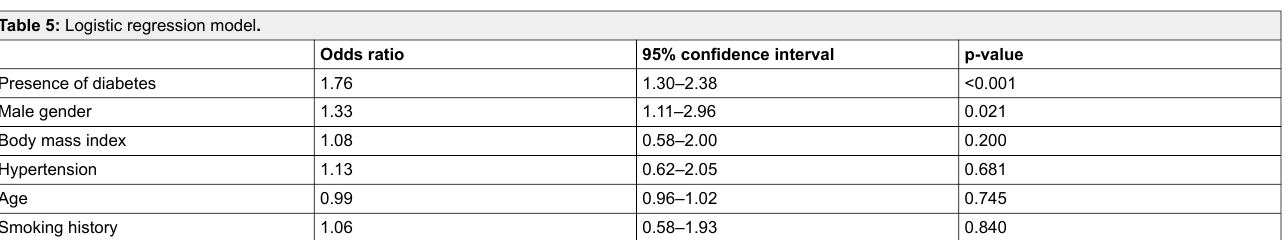
Table 5: Logistic regression model